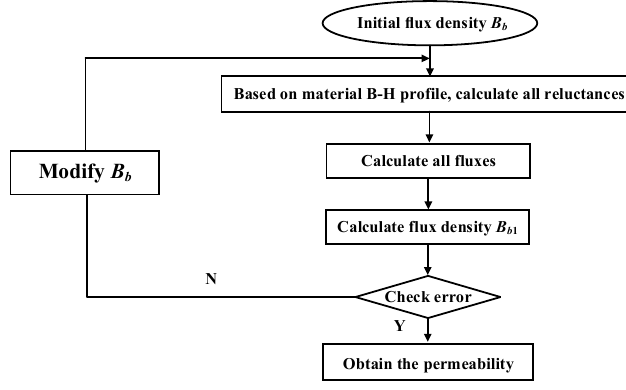
Figure 5. Flow chart of the iterative process.